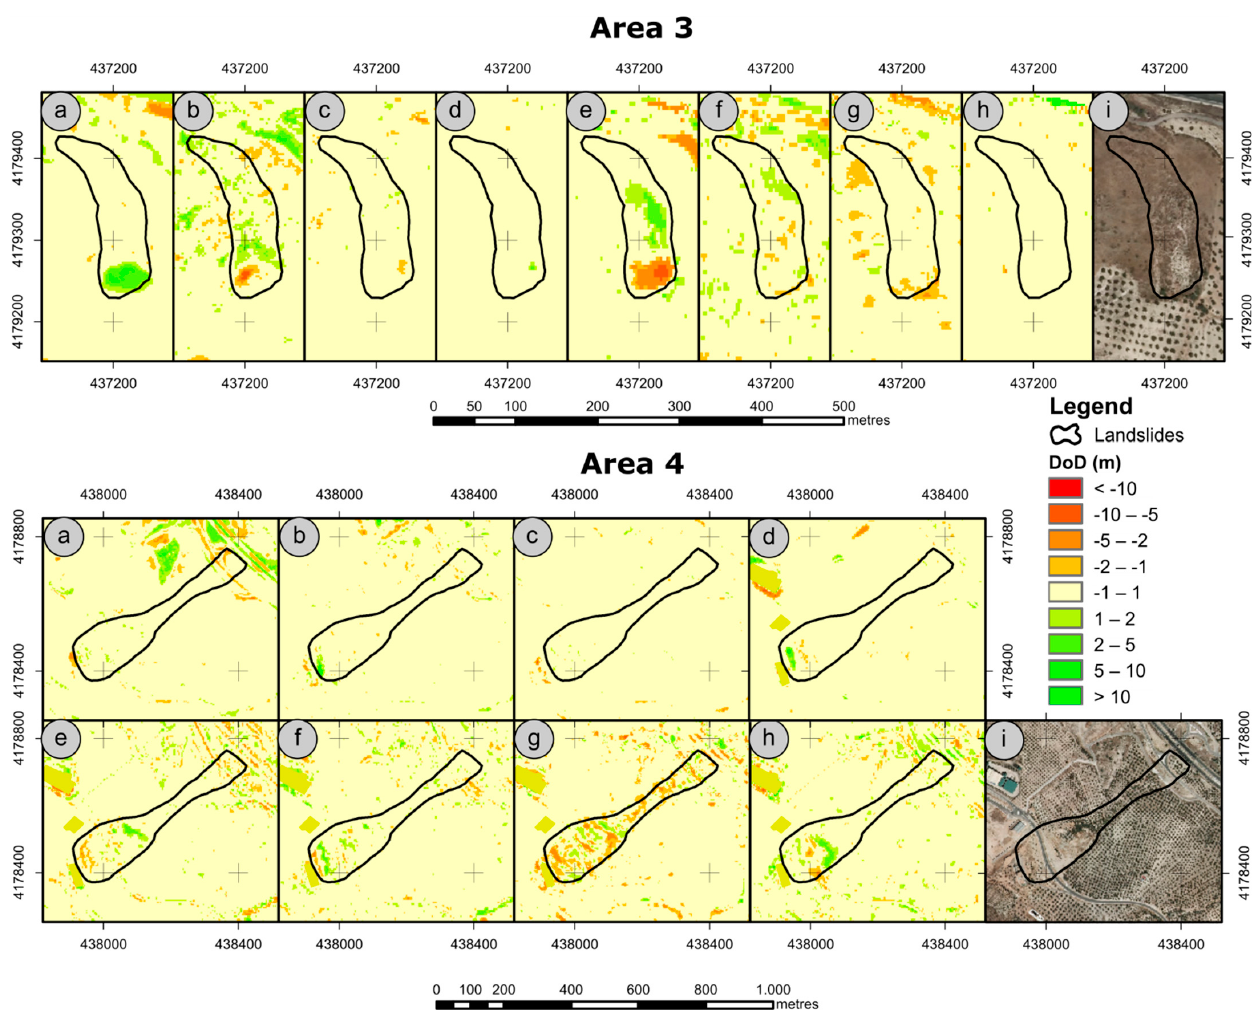
Figure 8. DoDs of areas 3 and 4: ( a ) 1984–1996; ( b ) 1996–2001; ( c ) 2001–2005; ( d ) 2005–2009; ( e ) 2009–2010; ( f ) 2010–2011; ( g ) 2011–2013; ( h ) 2013–2016; ( i ) orthoimages (2016). Coordinates are in ETRS89-UTM30. Locations of areas 3 and 4 are shown in Figure 6.